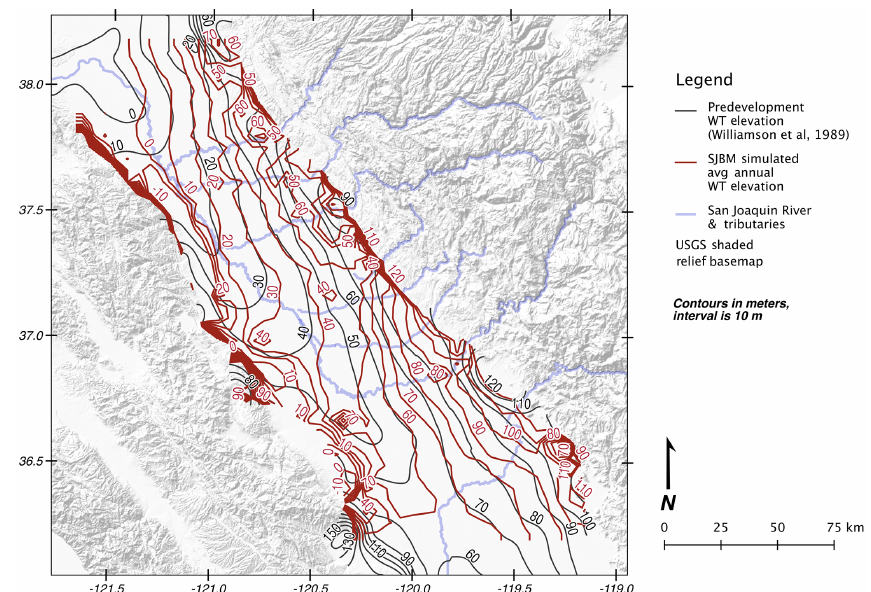
Figure 2. Pre-development water table comparison. Red contours are mean annual effective water table elevation (m) as simulated by the San Joaquin Basin model. Black contours are estimated pre-development water table elevation (m) converted from Williamson et al.